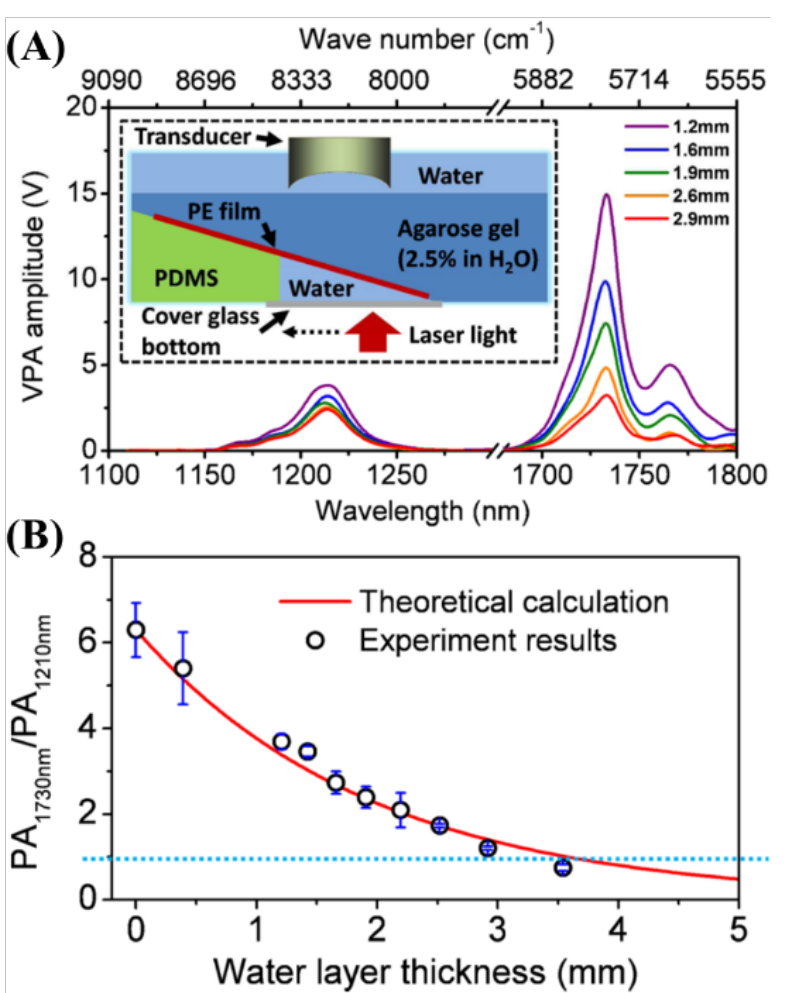
Figure 29. A phantom study that evaluates the effect of water on PA imaging in the near-infrared region. ( A ) PA spectra of PE at different water layer thicknesses. The inset shows a schematic of the constructed phantom. PE: polyethylene. ( B ) PA amplitude ratio between the first and second overtone excitation as a function of the water layer thickness. Adapted from Wang et al., J. Biophotonics, 2012. Reprinted from Wang et al., J. Phys. Chem. Lett., 2013, 4, 13; 2177–2185 [46], with permission of the American Chemical Society.